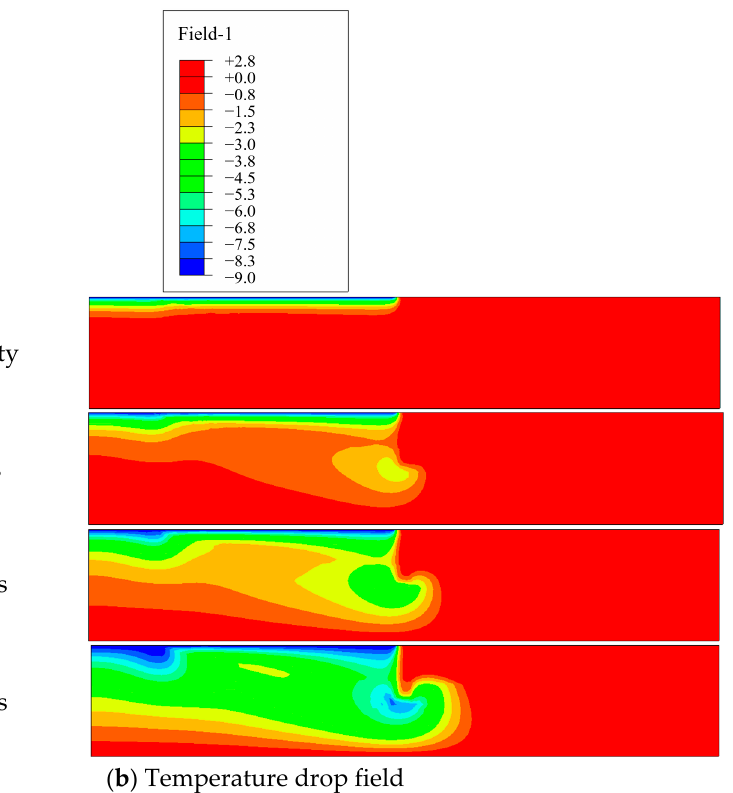
Figure 14. Temperature fields and temperature drop fields of bedrock with different permeability coefficients after 10 years of reservoir impoundment (unit: °C).